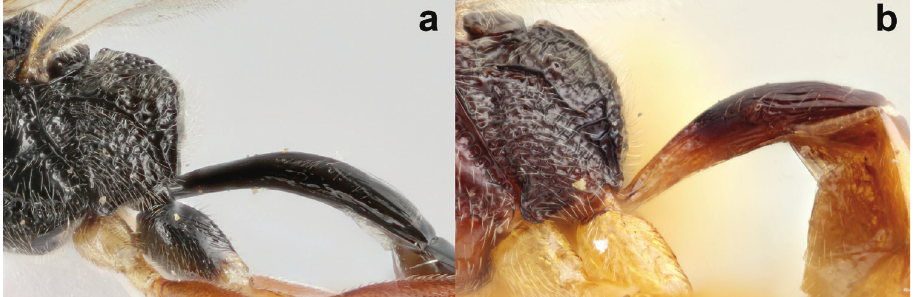
Figure 6. Comparison of propodeum and first metasomal segment of a Orionis coxator and b Perilitus rutilus